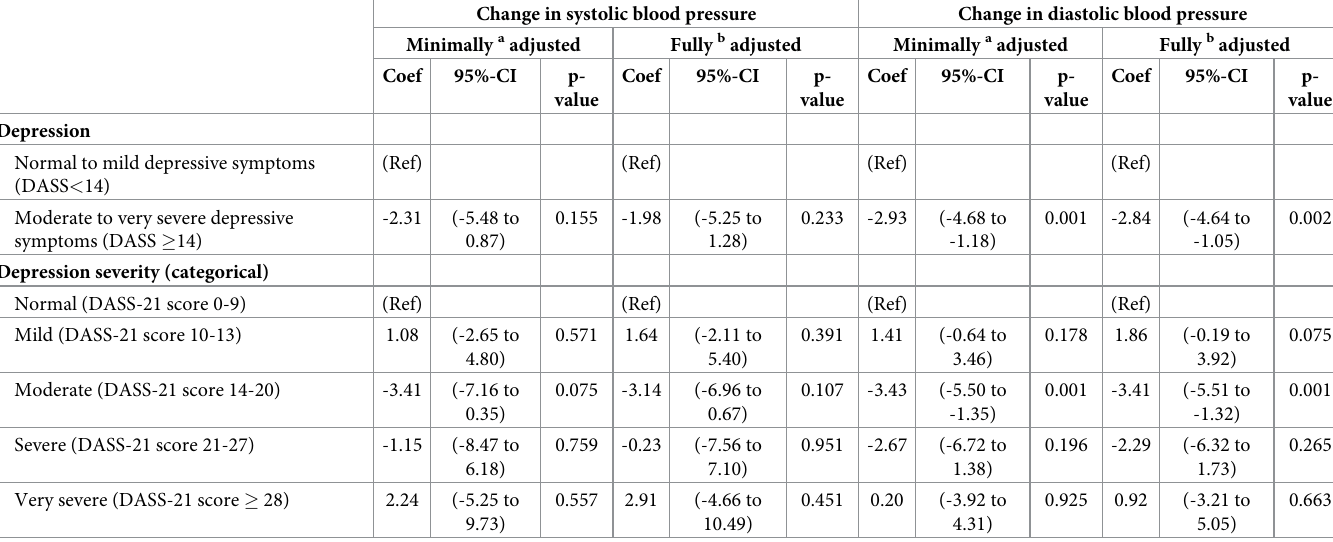
Table 3. Prospective association between depression and change in systolic and diastolic blood pressure per year. Change in systolic blood